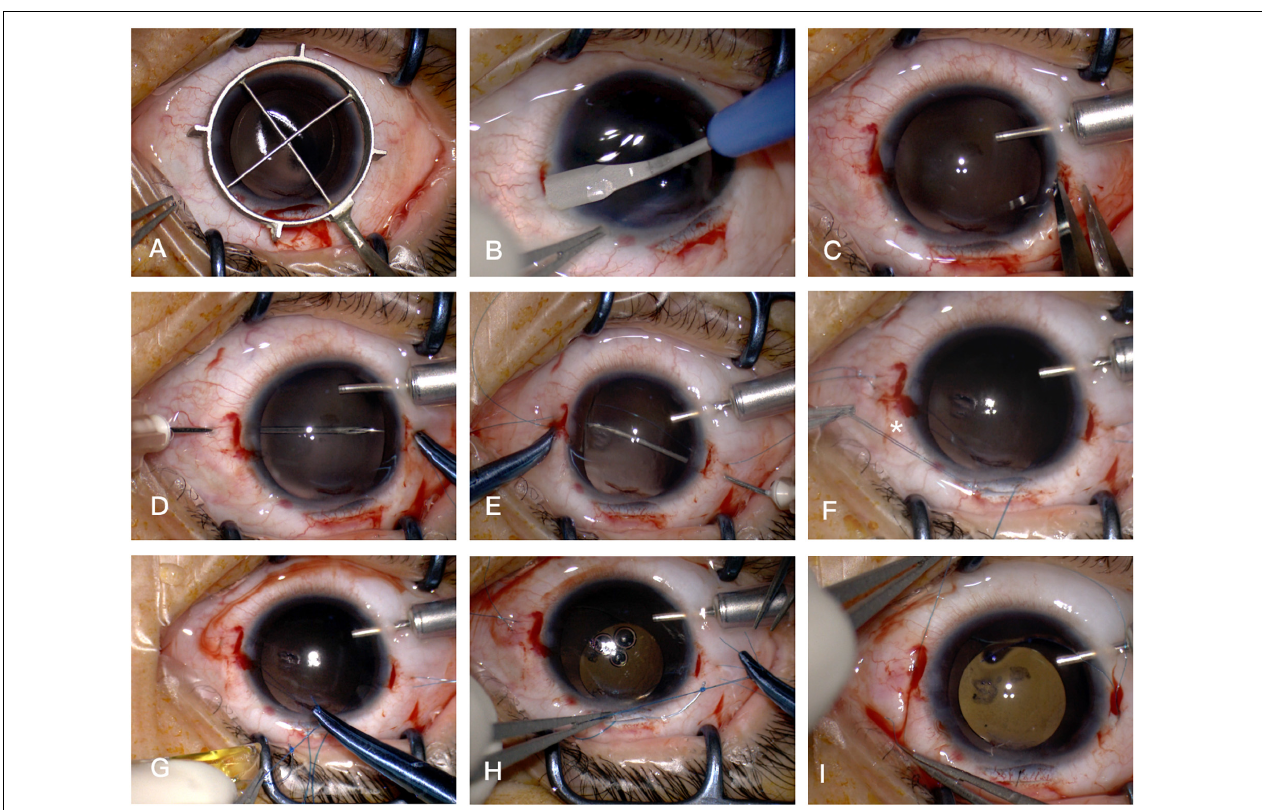
FIGURE 1 | Surgical steps. (A) Two location imprints at 3 o’clock and 9 o’clock are made by an ophthalmic marker. (B) Two scleral pockets are dissected by a crescent blade posteriorly from the limbus, achieving a thickness of 300 µ m and a length of 3.0 mm. (C) After anterior chamber infusion, puncture points are marked at the middle line of the pocket beds 2.0–2.5 mm posterior to the limbus on both sides. (D) The straight needle of a double-armed 9-0 polypropylene suture (with two curved needles) is introduced at one puncture point at 9 o’clock through the conjunctiva and full thickness of the Hoffman pocket, passing through the anterior chamber to the opposite side, then docked into the opening of a 27-G needle, which is introduced at the other puncture point at 3 o’clock, then removed externally. (E) The straight needle is again passed backward through the conjunctiva and the full thickness of the scleral pocket 1.0–2.0 mm adjacent to the first pass of the needle, threading through the anterior chamber and docked again with the 27-G needle, and guided out in the same way 1.0–2.0 mm adjacent to the puncture point at 9 o’clock. (F) The pairs of sutures are retrieved externally through the superior incision and cut into two halves. The star symbol demonstrates one end of the double sutures to tie on the leading haptic. (G) The leading haptic of the pre-loaded PIOL is pushed out of the cartridge and tied with one of the double sutures at the junction of the enlarged haptic end. (H) After the leading haptic and the folded IOL optic is injected into the anterior chamber, the trailing haptic left externally is tied with the other double sutures. (I) The two pairs of suture ends are retrieved through the scleral pocket opening pulled out by the Sinskey hook and knotted via tension adjustable knot to center the optic of the IOL.